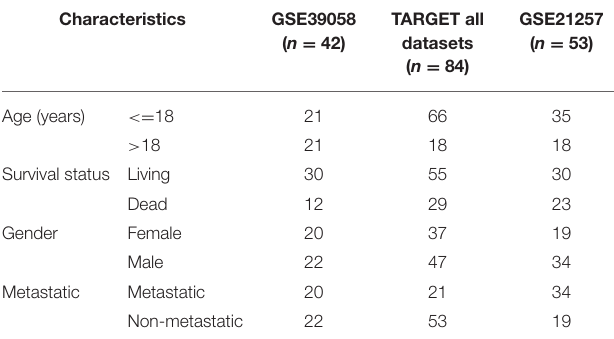
TABLE 2 | Detailed sample information of internal and external